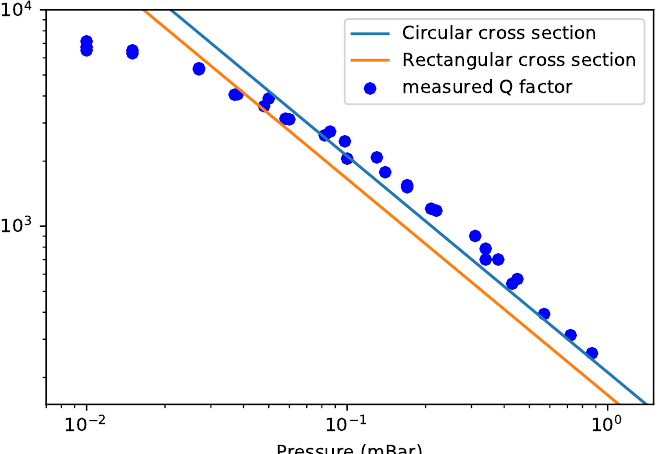
Figure 13. Measured and theoretically predicted Q factor for the swing mode in the molecular flow